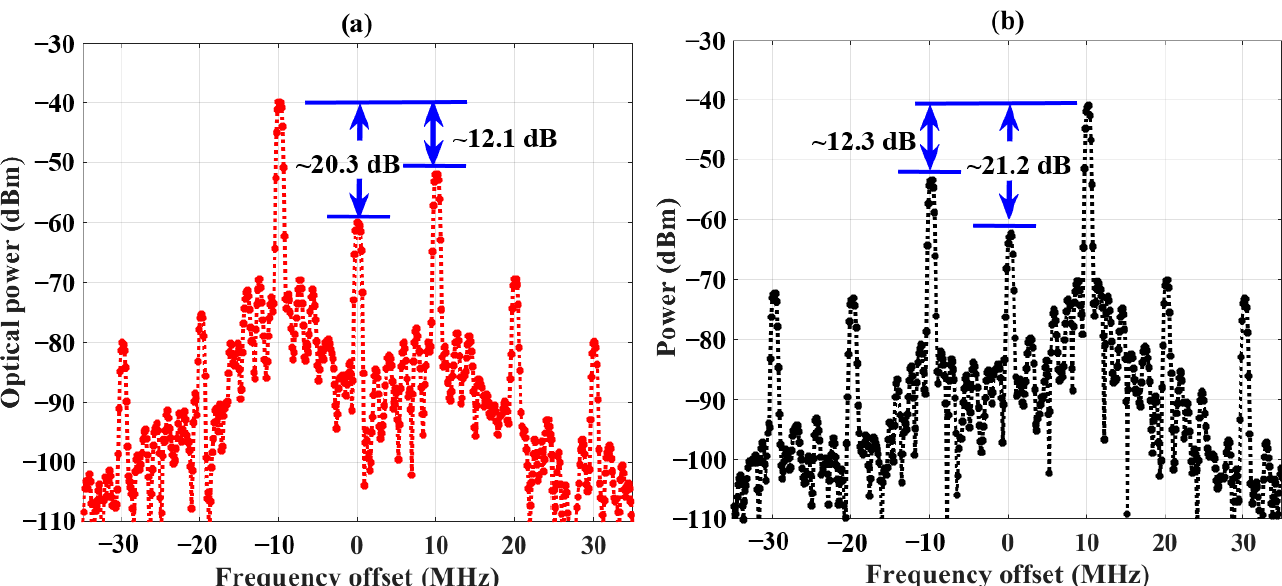
Figure 8. Optical spectra showing ( a ) frequency down-conversion at output port O 1 , and ( b ) frequency up-conversion at output port O 4 . The reference frequency is 193.4125 THz, and the resolution bandwidth of the optical modulation analyzer is 668.388 kHz.